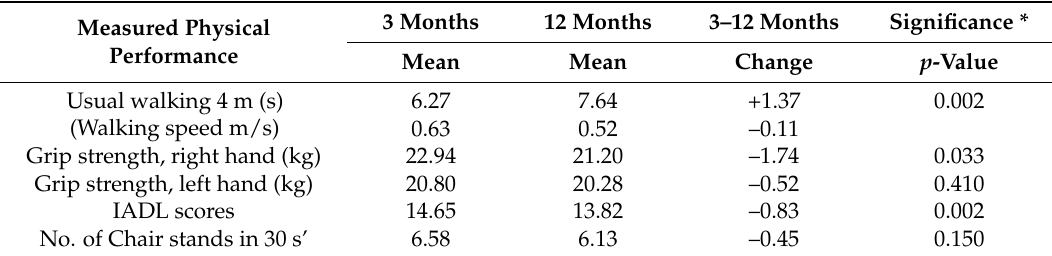
Table 5. Measured physical performance parameters and changes in them 3 and 12 months after moving to senior